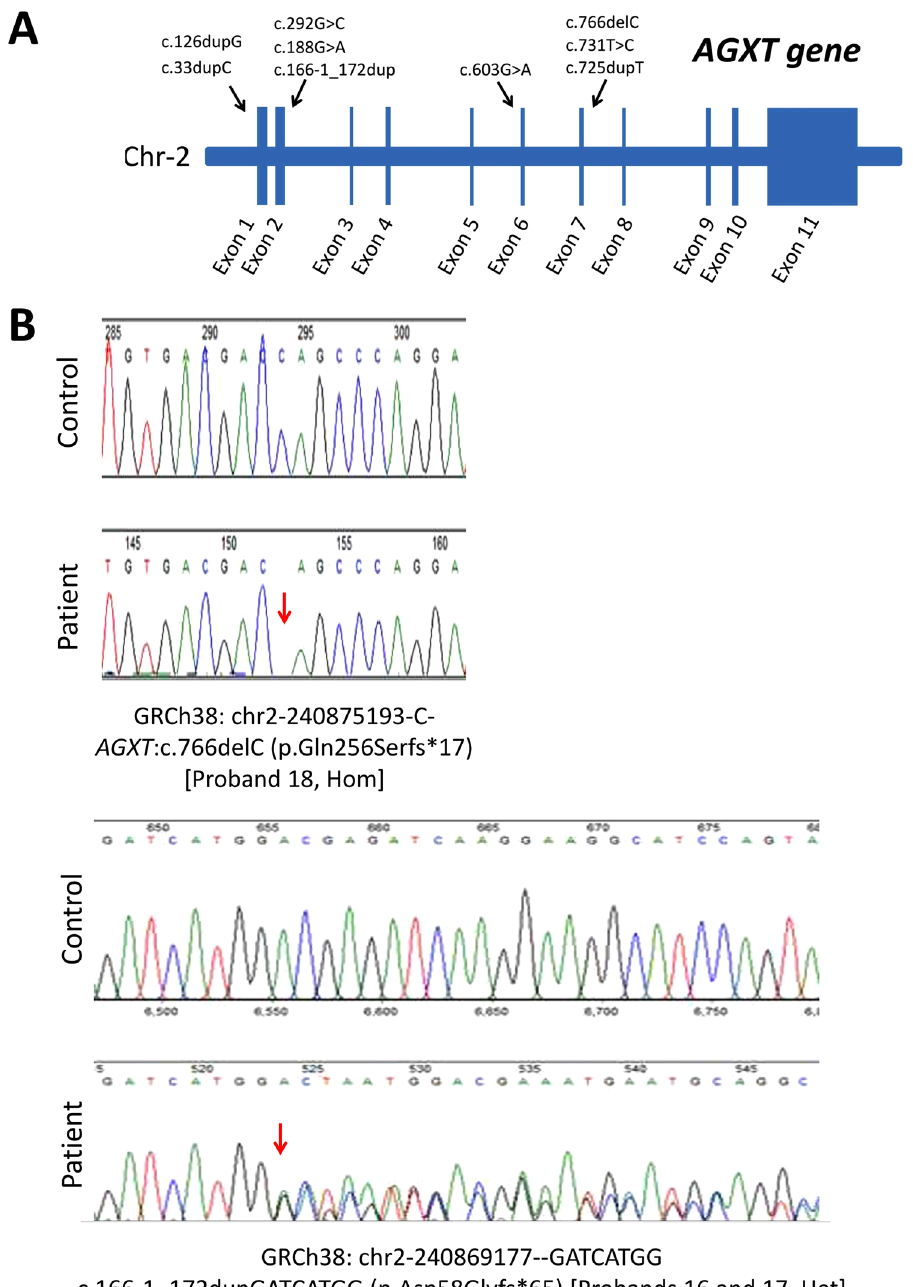
Figure 2. ( A ) A schematic representation of AGXT gene exons showing all pathogenic variants detected in Egyptian PH patients. ( B ) Novel variants in the AGXT gene in Egyptian patients: c.766delC (p.Gln256Serfs*17) and c.166-1_172dupGAT CAT GG (p.Asp58Glyfs*65) compared with a normal individual. Het: heterozygous, Hom: